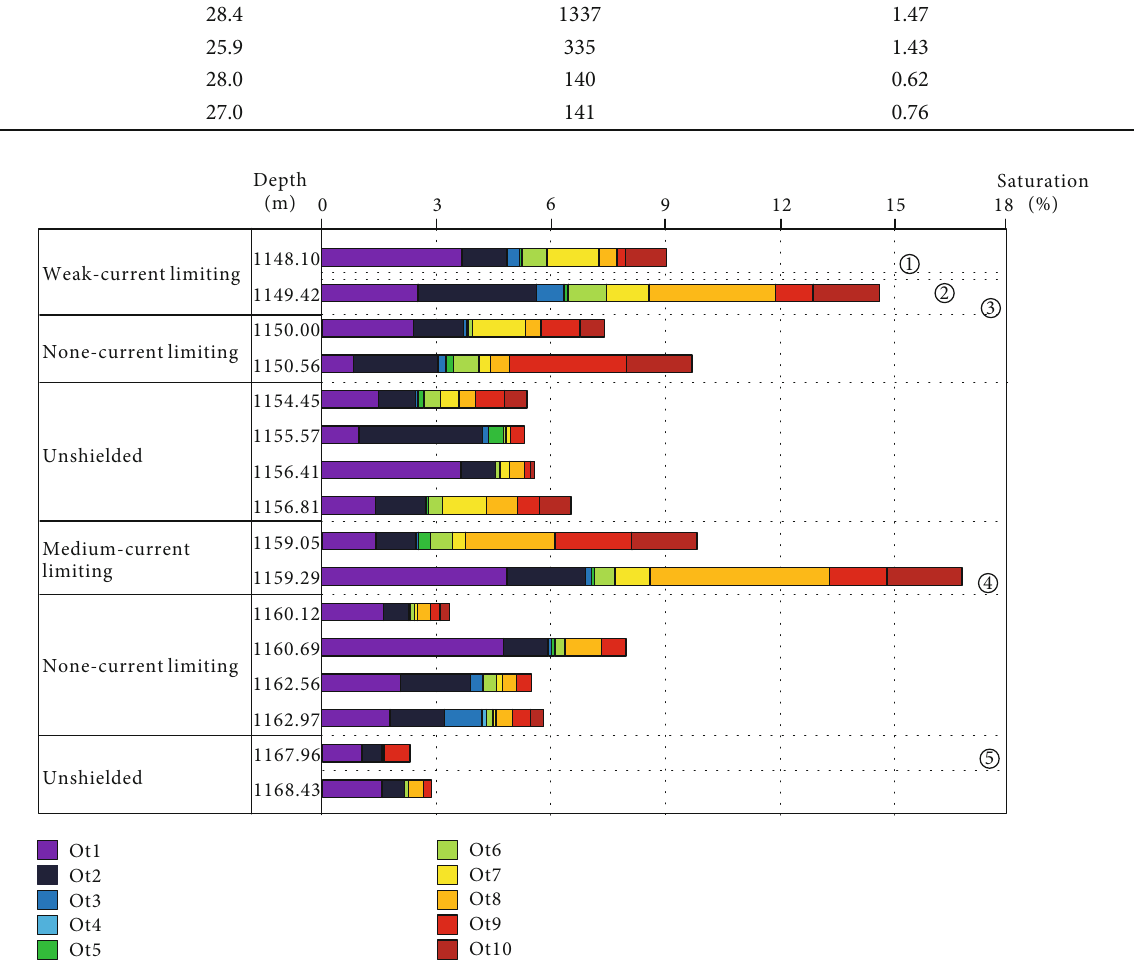
Figure 18: Saturation of microscopic remnant oil in di ff erent fl ow